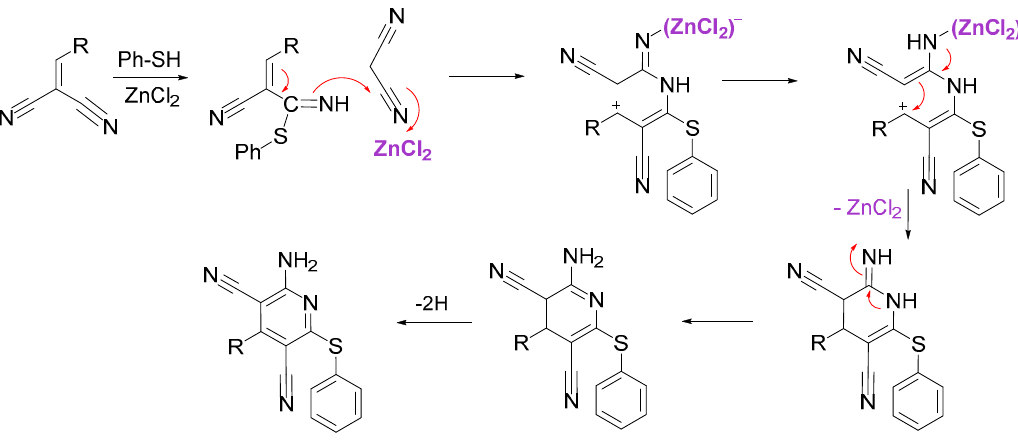
Figure 5. Reaction mechanism theorized when the Lewis acid ZnCl 2 was used.